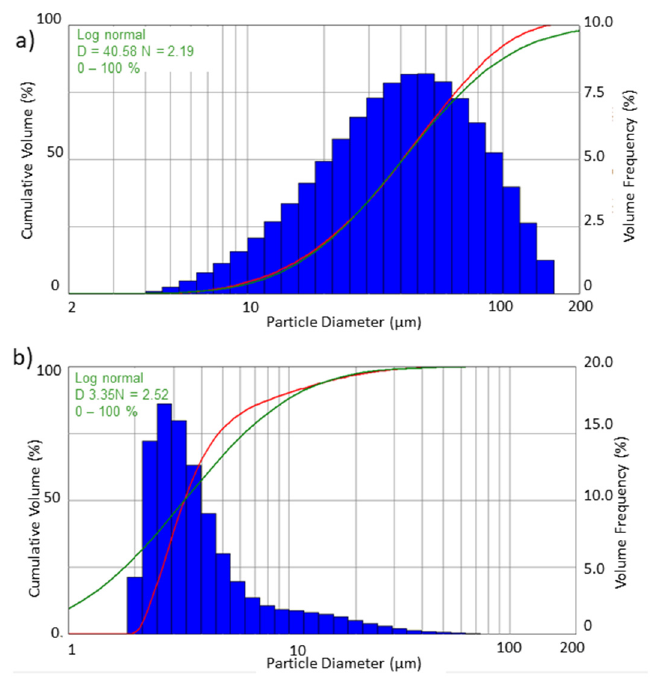
Figure 5. Histograms—F1 filter, 20 cm distance: ( a ) volume distribution of the recorded droplet diameters, ( b ) numerical distribution of recorded droplet diameters.